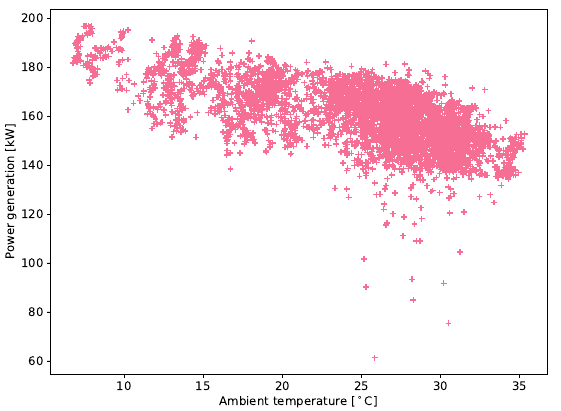
Figure 3. Heatmap of a correlation matrix for PV generation and local weather data fields in the NIST dataset.